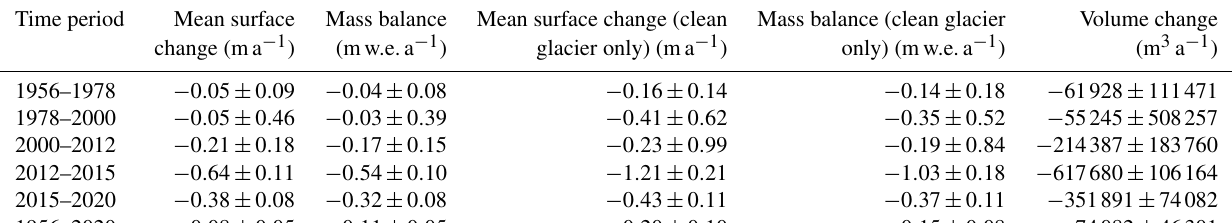
Table 4. Summary of total glacier (clean ice and debris-covered ice) area changes, mean surface change, and geodetic mass balance for Tapado Glacier between 1956 and 2020.